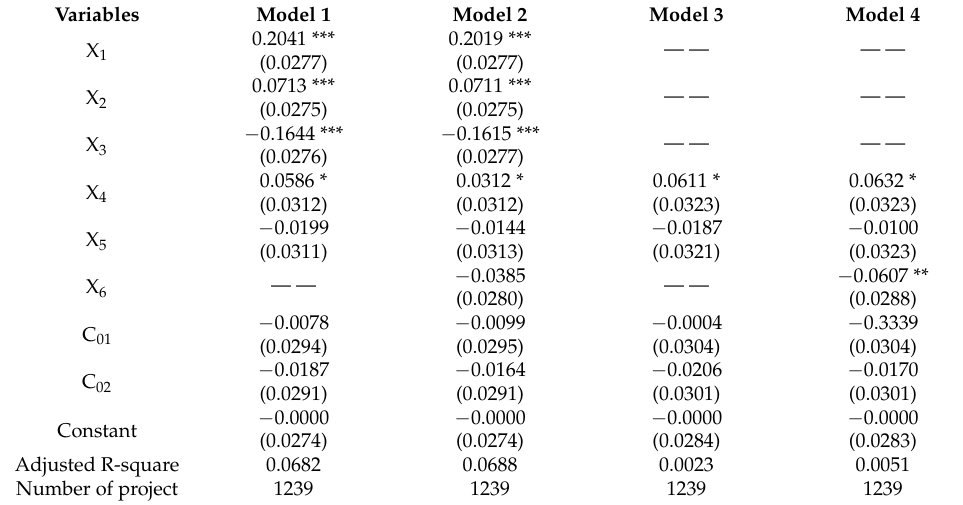
Table 7. Results of the multiple regression